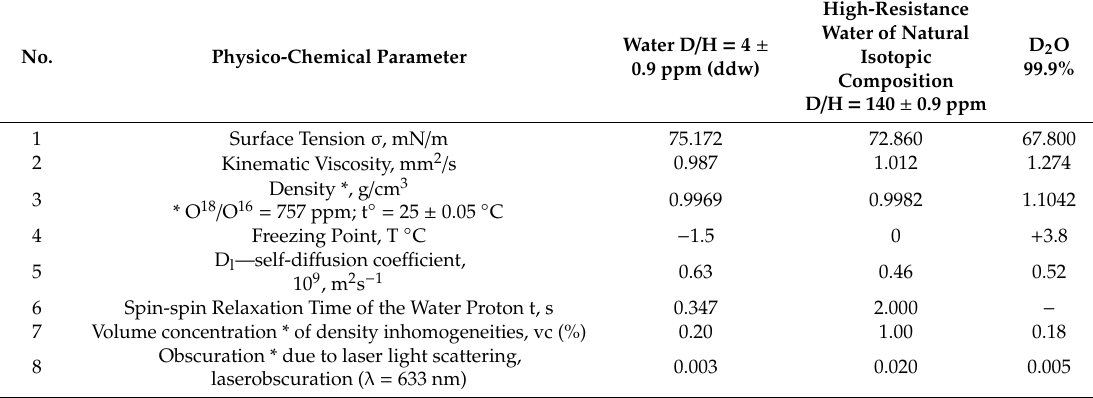
Table 1. Some physico-chemical properties of water with di ff erent heavy isotope contents 2 (T = 20.00 ± 0.04 ◦ C) [8]. (*—according to the LALLS method